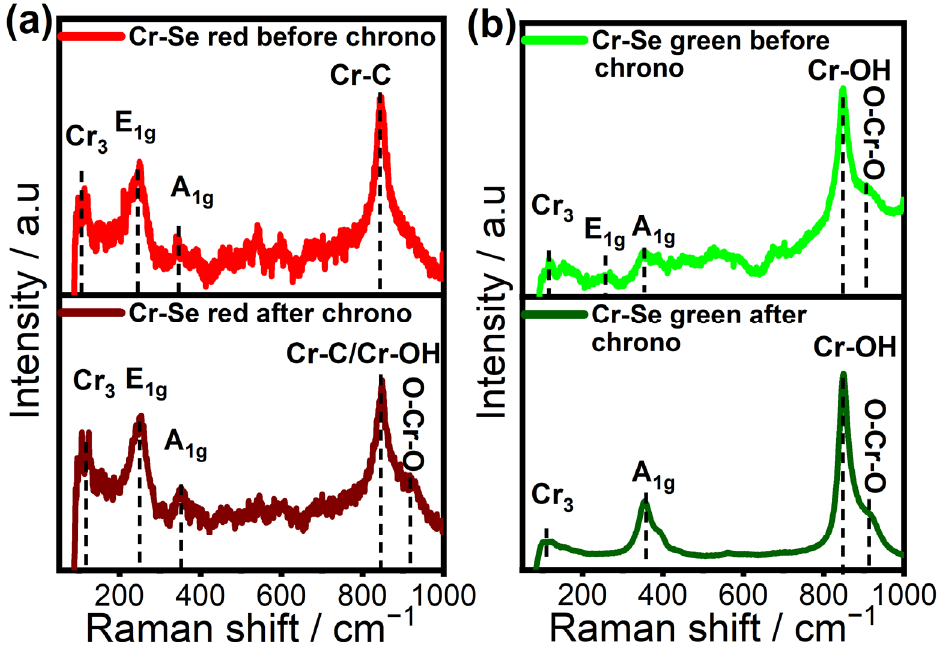
Figure 6. Raman spectra, excited with 632.8 nm HeNe laser radiation of ( a ) Cr–Se red complex before and after chronoamperometry study; ( b ) Cr–Se green complex before and after chronoamperometry study.